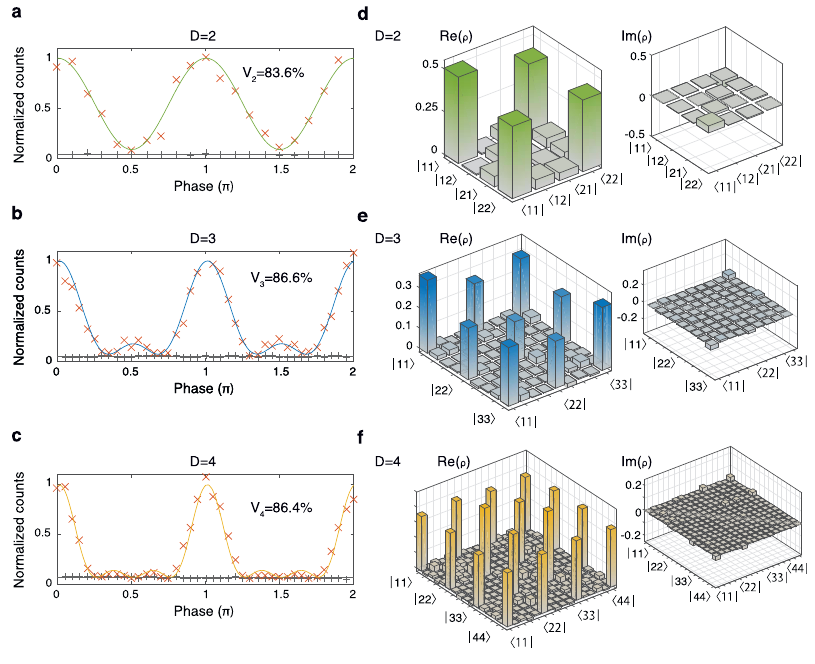
ef fi ciency, our quantum state analysis focused on the d = 2, 3, and 4 level cases. To validate the presence of two-photon entanglement, we extracted the visibility from the retrieved quantum interference. Raw (without background subtrac- tion) visibilities of V d = 83.6%, V d = 86.6%, and V d = =2 =3 =4 86.4% were measured for d = 2, 3, and 4, respectively (see Figure 2a – c). All these values exceed their respective Bell inequality violation thresholds of 70.7, 77, and 81.7%, thus con fi rming the generation of two-photon entangled qudits.